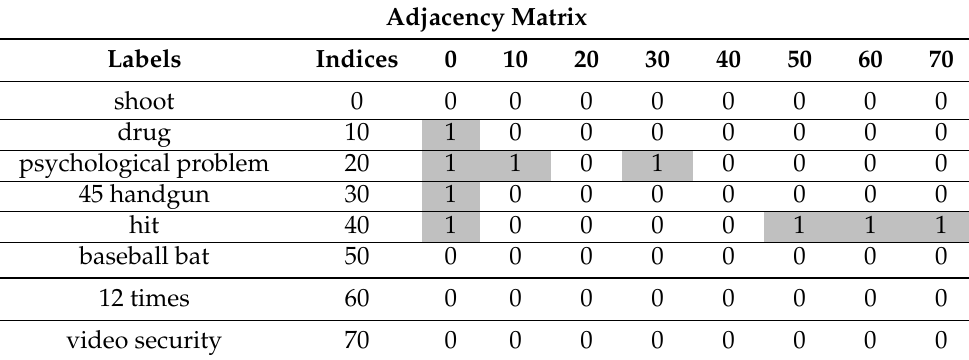
Table A3. The adjacency of the elements of a case in Figure 14.